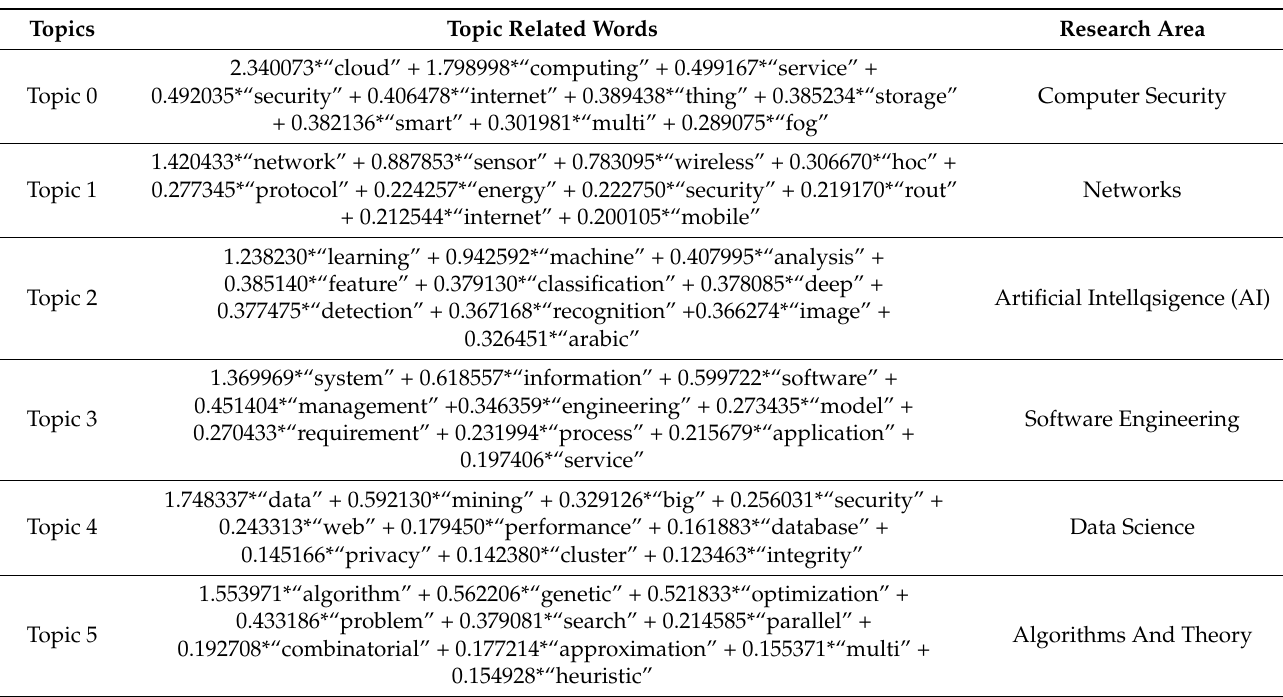
Table 7. Topics’ specifications.